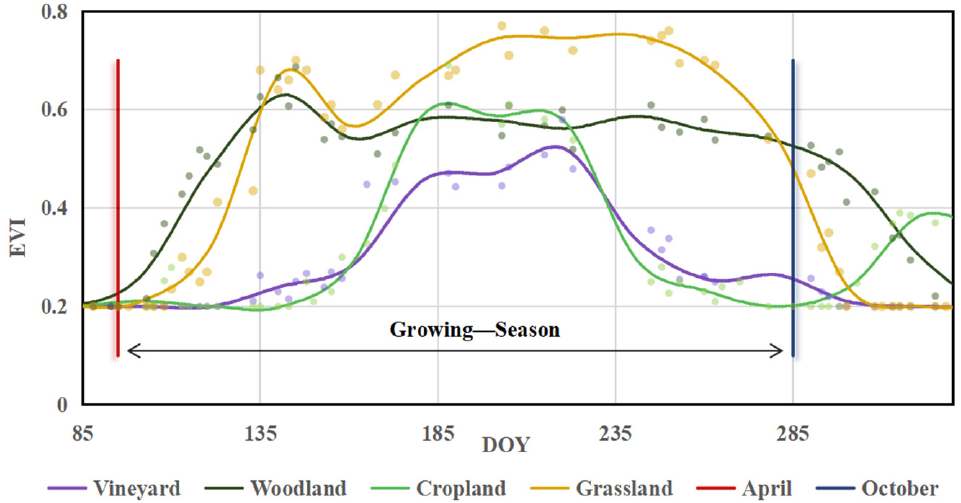
Figure 5. Temporal patterns of EVI for vineyard, woodland, cropland, and grassland. The dots rep-